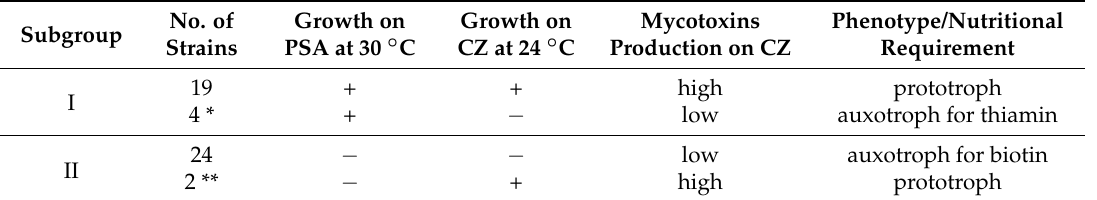
Table 2. Characterization of F. langsethiae strains belonging to the different